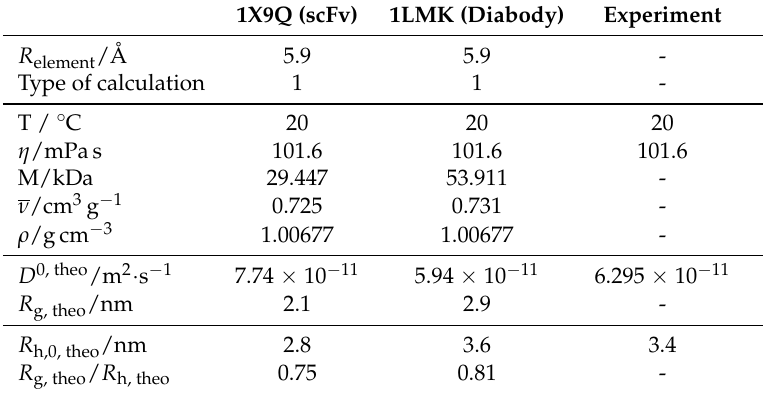
Table 3. Calculated hydrodynamic properties, R element consists of 2.9Å (recommended by the software) for one element and 3Å for the first hydration shell, the calculation is based on the: atomic level primary model, shell calculation (type 1). The listed experimental values are extrapolations for infinite dilution. Here, ν is the specific average volume of a protein, ρ and η are the density and the viscosity of the buffer. 1X9Q (scFv) 1LMK (Diabody) Experiment R element /Å 5.9 5.9 - Type of calculation 1 - T / ◦ C η